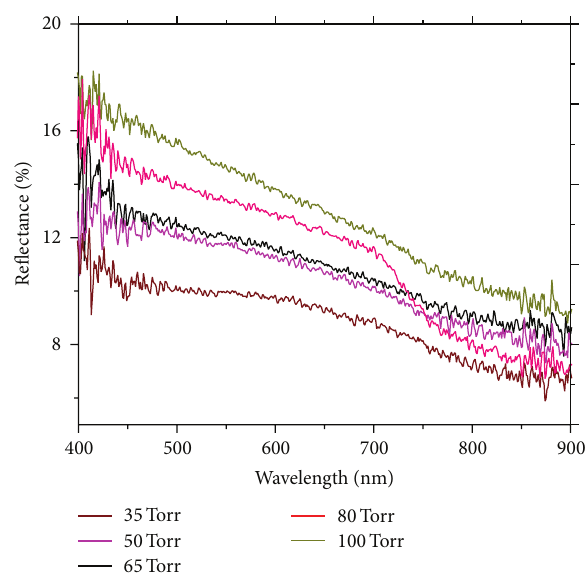
Figure 6: Reflection of the diamond films deposited under working pressure ranged from 35 Torr to 100